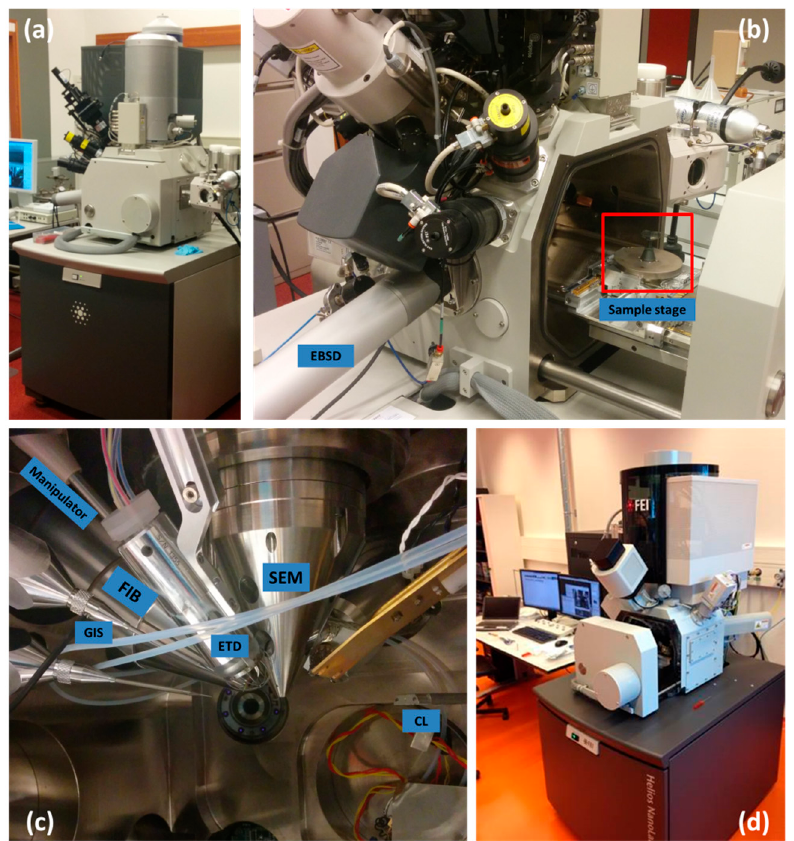
Figure 3. ( a ) FIB-SEM of FEI Nova NanoLab 600 (FEI Company, Hillsboro, OR, USA) at Utrecht University; ( b ) its sample stage (marked by red rectangle) and ( c ) its inner chamber; ( d ) the FEI Helios NanoLab G3 UC (FEI Company) at Utrecht University.